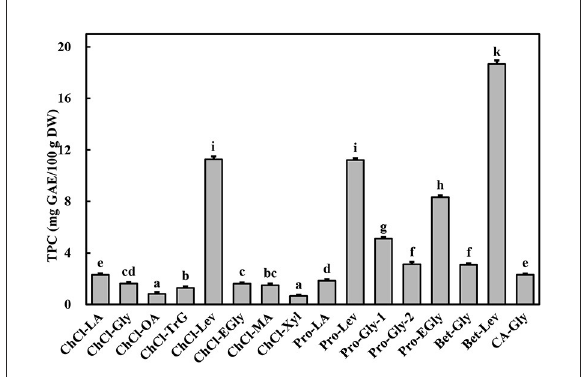
FIGURE1 Total phenolic content (TPC) of Asparagopsis taxiformis extracts gained by UAE with different DESs. Different letters indicate significant differences ( p < 0.05).